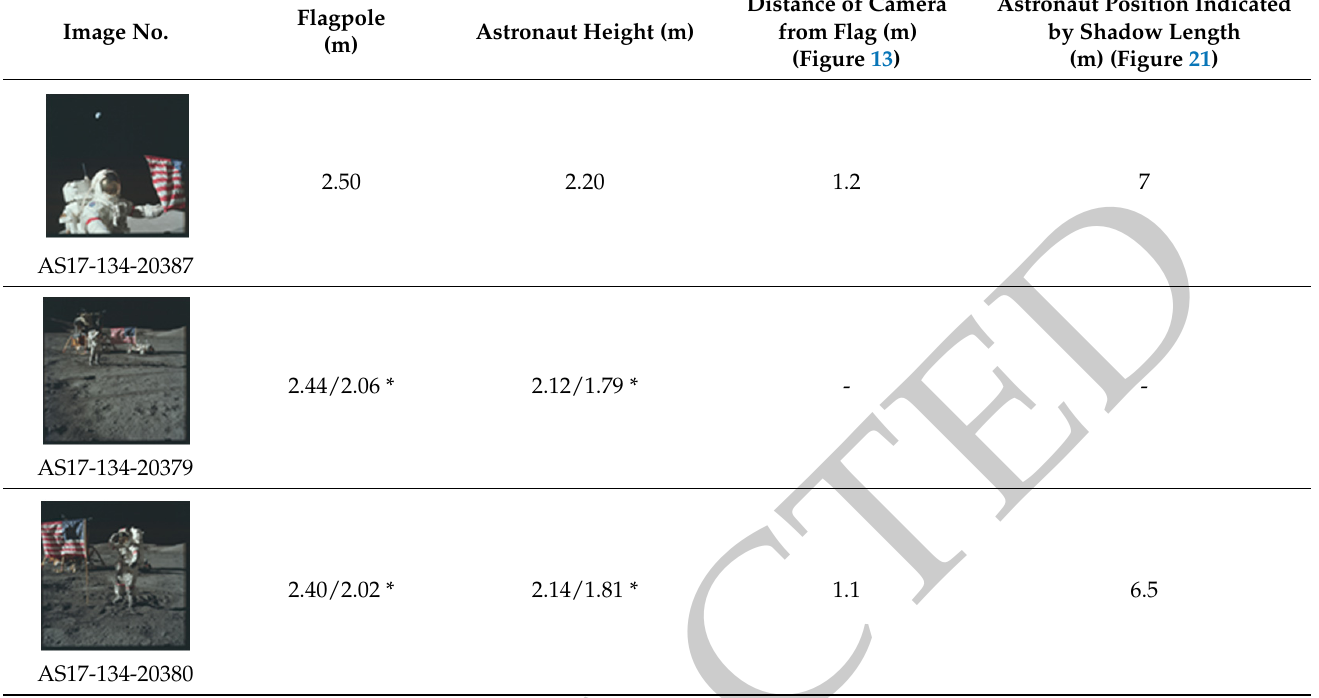
Table 2. Estimation of various heights imaged in photos for flag size 1.09 m × 1.83 m unless otherwise noted. Image No.